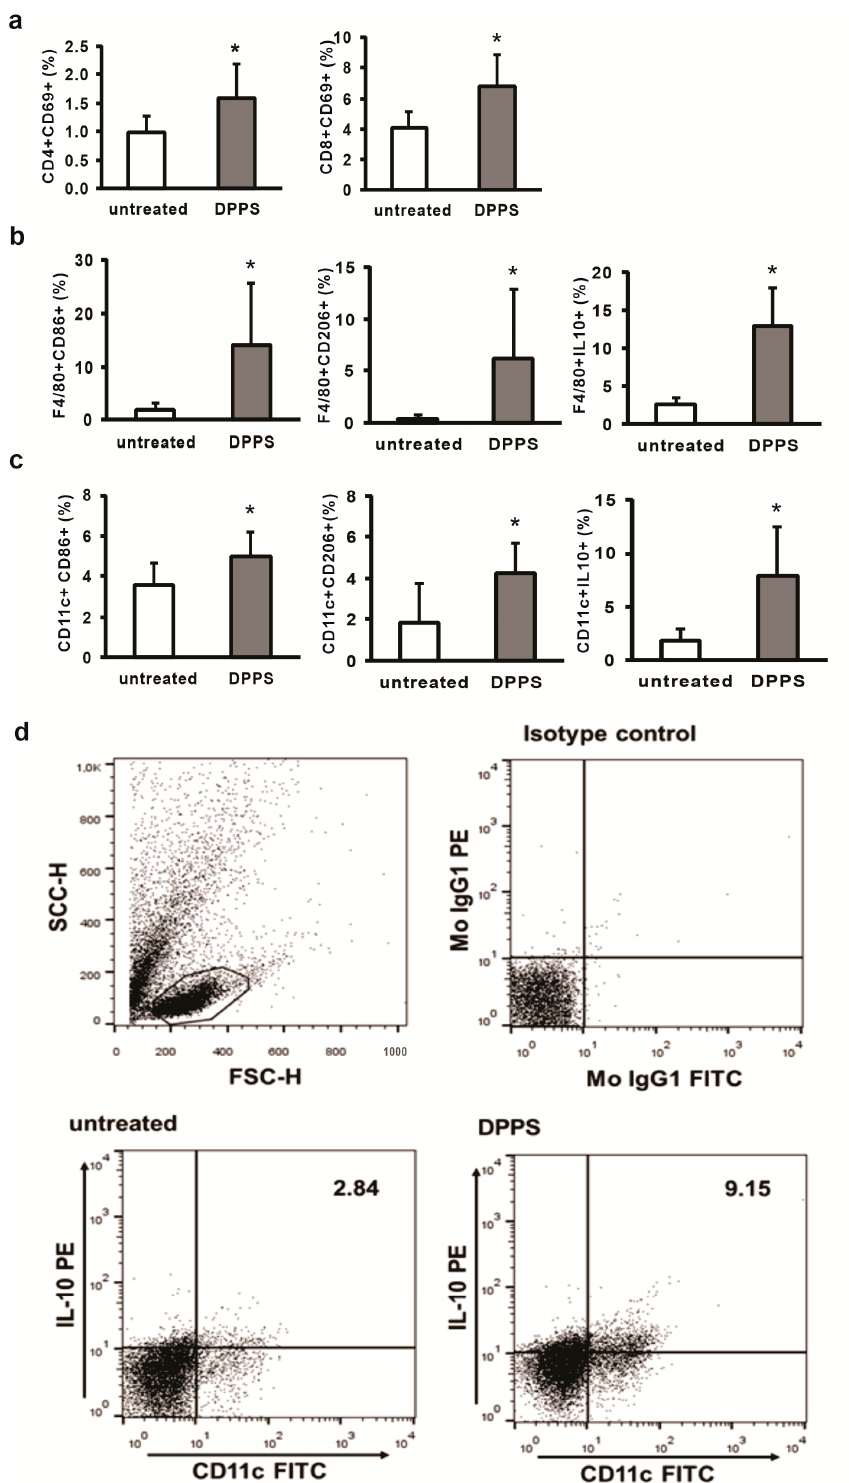
Figure 2. Pretreatment with dipropyl polysulfides (DPPS) increases percentage of activated and regulatory macrophages and DCs in the liver. ( a ) Percentage of activated, CD69-positive, CD8+ and CD4+ cells, ( b ) F4/80+ macrophages and ( c ) CD11+ dendritic cells, expressing marker of classical (CD86) and alternative activation (CD206) and anti-inflammatory cytokine IL-10, determined by flow cytometry of mononuclear cells isolated from the livers of untreated mice and 6 h after oral treatment with DPPS, and gating strategy for detection of double-positive cells ( d ). Data are presented as mean + SD (* p < 0.05; two-tailed, unpaired Student’s t -test).